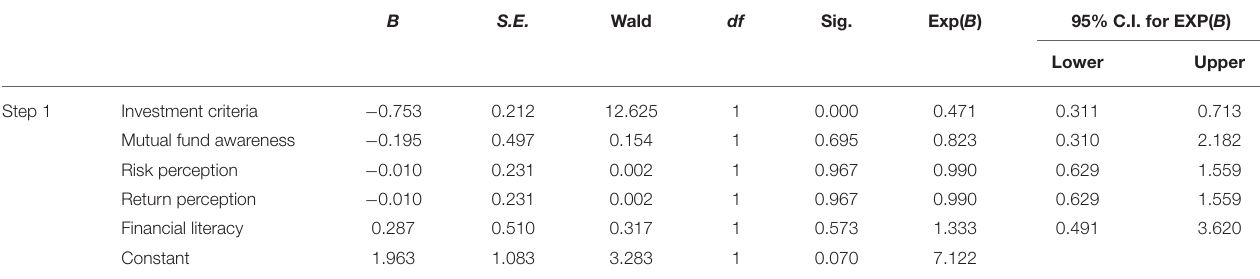
TABLE 4 | Variables in the equation.